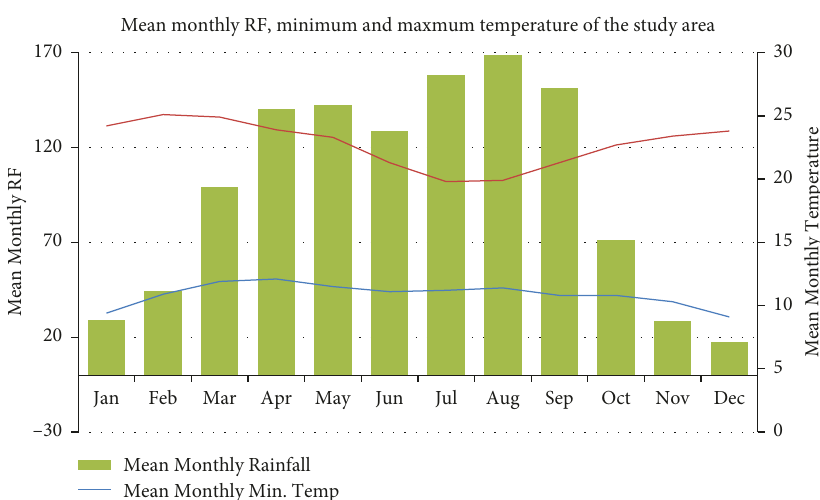
Figure 2: Climate data collected from Hossaina, a center nearest to the study site